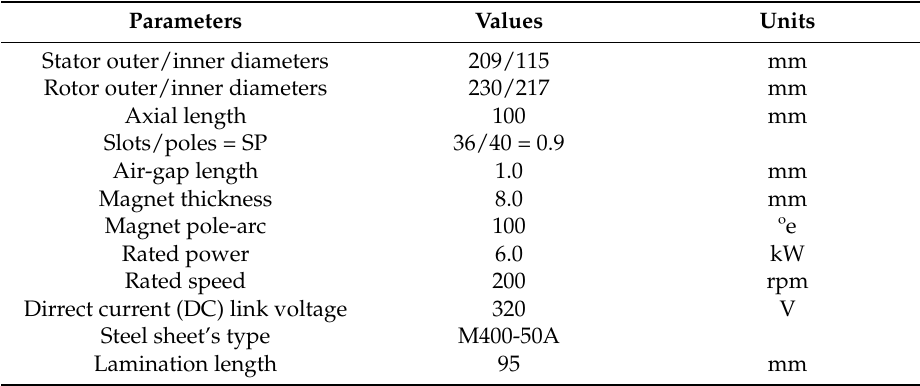
Table 1. Specifications of the proposed permanent magnet synchronous machine